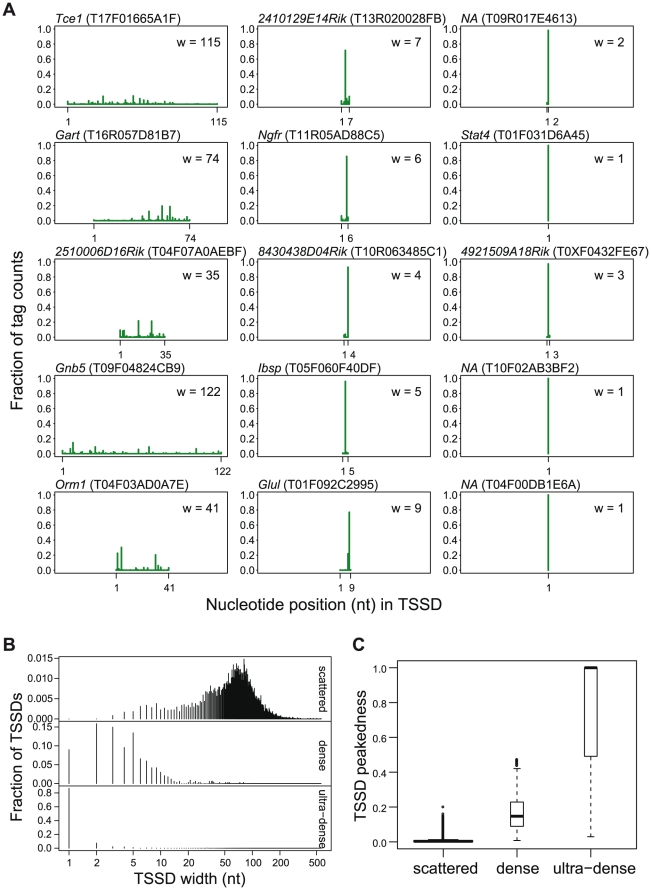
Properties of “scattered”, “dense” and “ultra-dense” TSSD clusters.(A) Examples of individual TSSDs of respective class: scattered TSSDs(left column), dense TSSDs (middle column) and ultra-dense TSSDS (right column) . The X-axis shows the relative genomic position with the 5′ end of the distribution is placed at coordinate 1. The Y-axis shows the fraction of the tags. The text above each distribution gives gene names or transcriptional unit identifiers of the TSSD in FANTOM3 database and the TSSD identifier is in brackets. The inset gives the width of the TSSD. (B) Distribution of the TSSD widths. The width distribution characterizes how dense the TSSDs are. Scattered, dense and ultra-dense TSSDs are in the top, middle, bottom panels, respectively. The X-axis shows the width of the TSSDs in unit of nt. Scattered TSSDs are mainly in the range from 20 nt to 200 nt; dense TSSDs are generally less than 20 nt long; ultra-dense TSSDs are in most cases 1 nt wide. (C) Box-plots showing the distribution of peakedness scores of individual TSSDs. Scattered, dense and ultra-dense TSSDs are in the left, middle, right boxes, respectively.